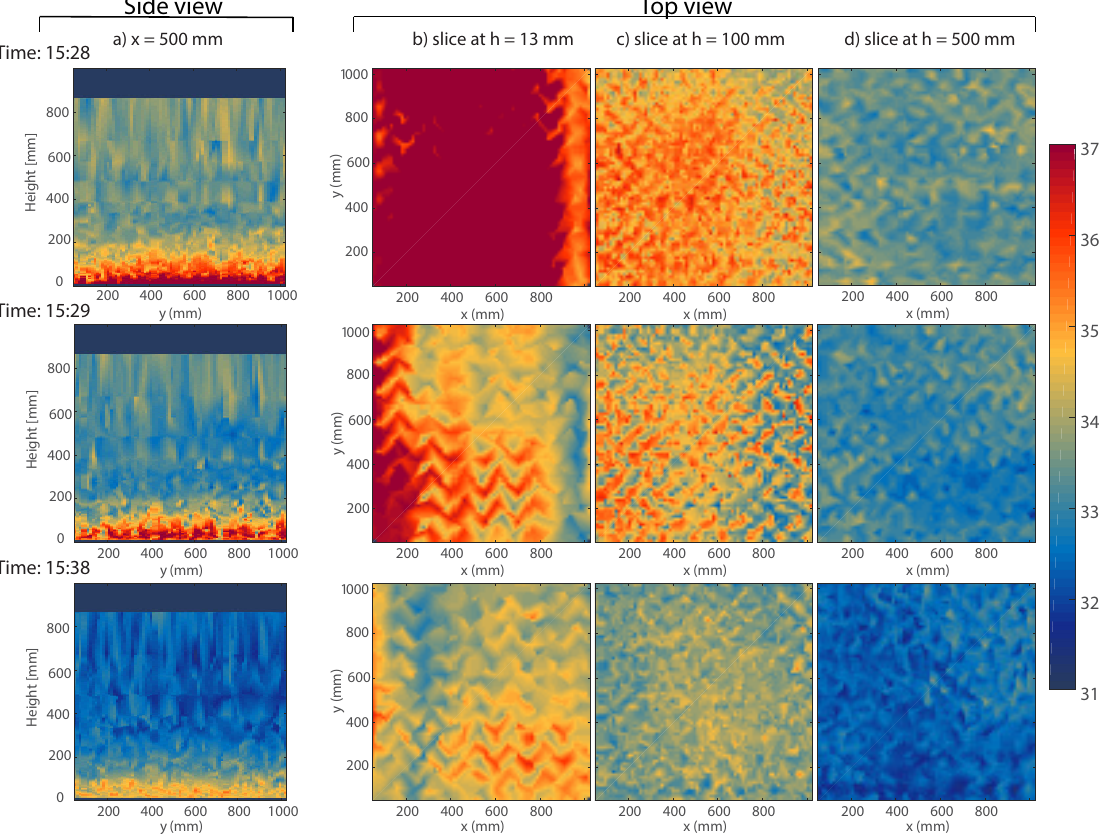
Figure 6. Vertical and horizontal profiles for the fourth experiment measured right before the uchimizu (15:28), right after (15:29), and 9 min after (15:38). The subplots in column ( a ) show vertical cross-sections through the middle of the setup ( x = 500 mm), and the subplots in columns ( b – d ) show horizontal cross-sections at height h = 13 mm, h = 100 mm, and h = 500 mm,